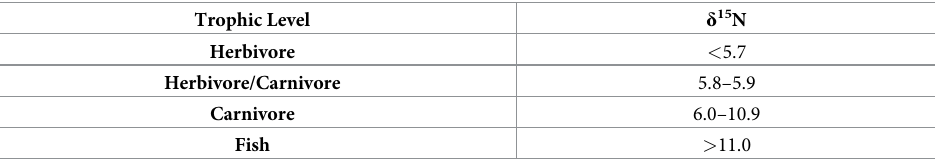
Table 3. Ranges of δ 15 N values for each vertebrate trophic position obtained from the literature review. Trophic